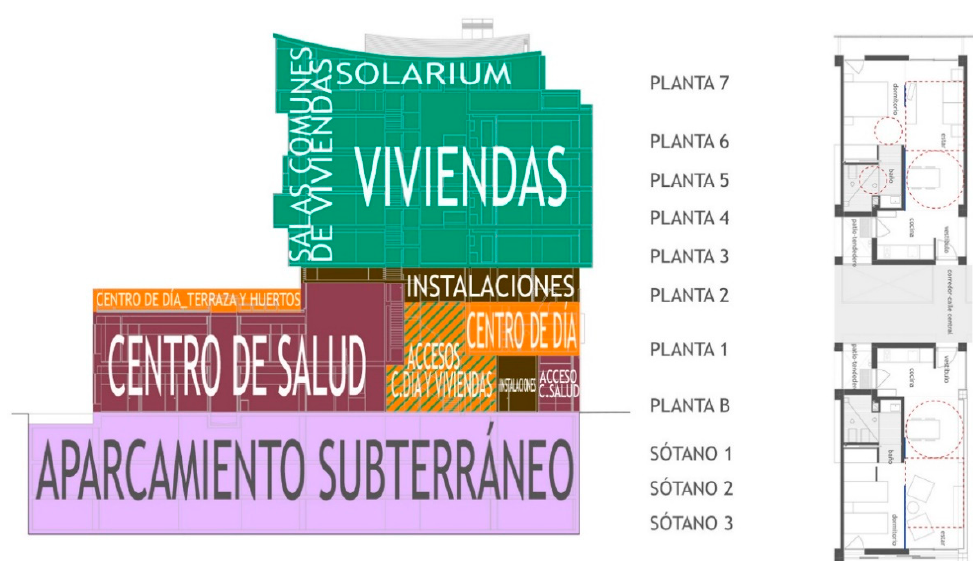
Figure 13. Cross-section diagram of the Plaza de America building (from bottom to top: − 1, − 2 & − 3 basement levels: parking; ground floor: community health center and main access; first floor: community health center and day care center; second floor: services, gardens and urban orchard; levels 3 to 6: dwellings and collective areas; seventh floor: sun deck and common facilities) and typical housing unit floorplan. Courtesy of Carmen Pérez Molpeceres and Consuelo Argüelles Álvarez.